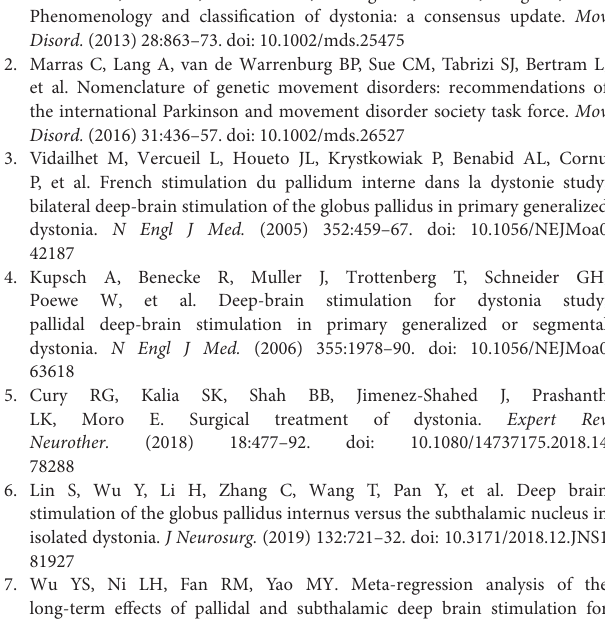
Supplementary Figure 1 | NMSS-PD total scale correlation to the quality of life improvement. Spearman correlation analysis, the only variable that revealed significant correlation was the QoL’s improvement to the NMSS-PD total scale. Supplementary Table 1 | Clinical information for patients with the study. Supplementary Table 2 | BPI, NPSI and MPQ scales scores in patients with or without pain. Data are presented as mean ± standard deviation (min–max), in which sample size is n = 4–7. Supplementary Table 3 | BFMRS, HADS and NMS scales scores in patients with or without pain. Data are presented as mean ± standard deviation (min–max), in which sample size is n =